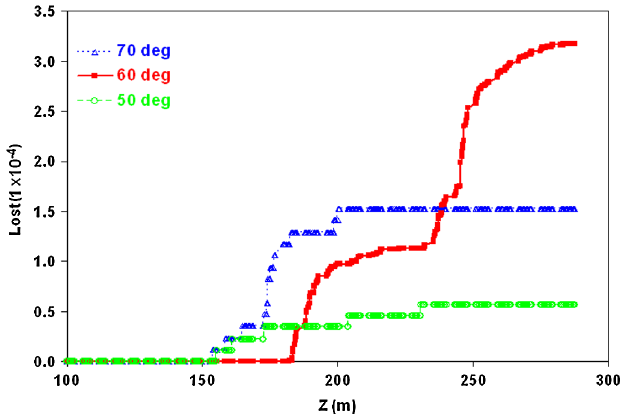
FIG. 11. Total SCL beam loss versus zero-current transverse phase advance with all SCL cavities off, and all dipole correctors at